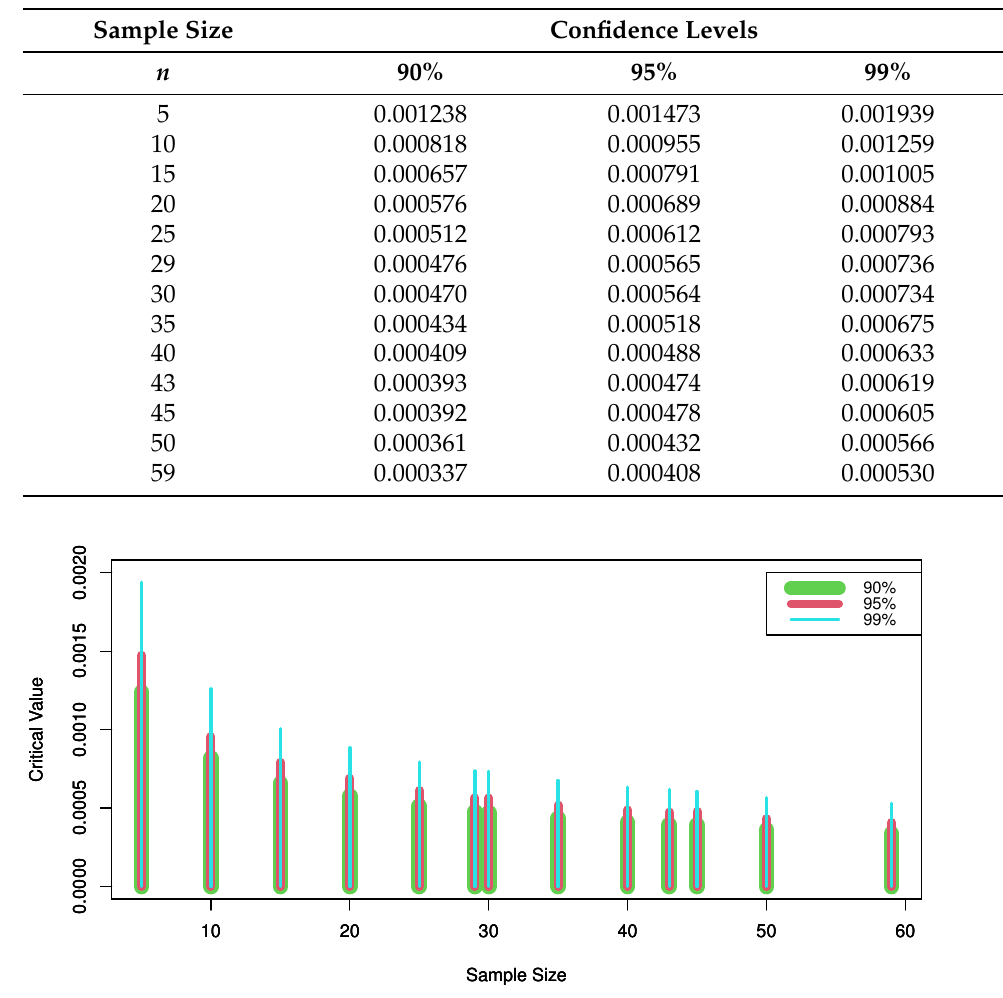
Figure 1. Relationship between the sample size, the level of confidence, and the critical